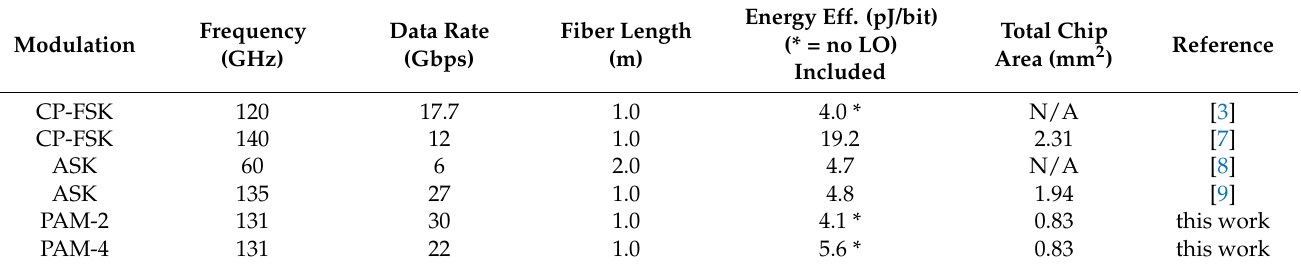
Table 2. Comparison with other PMF links, with BER < 10 − 12